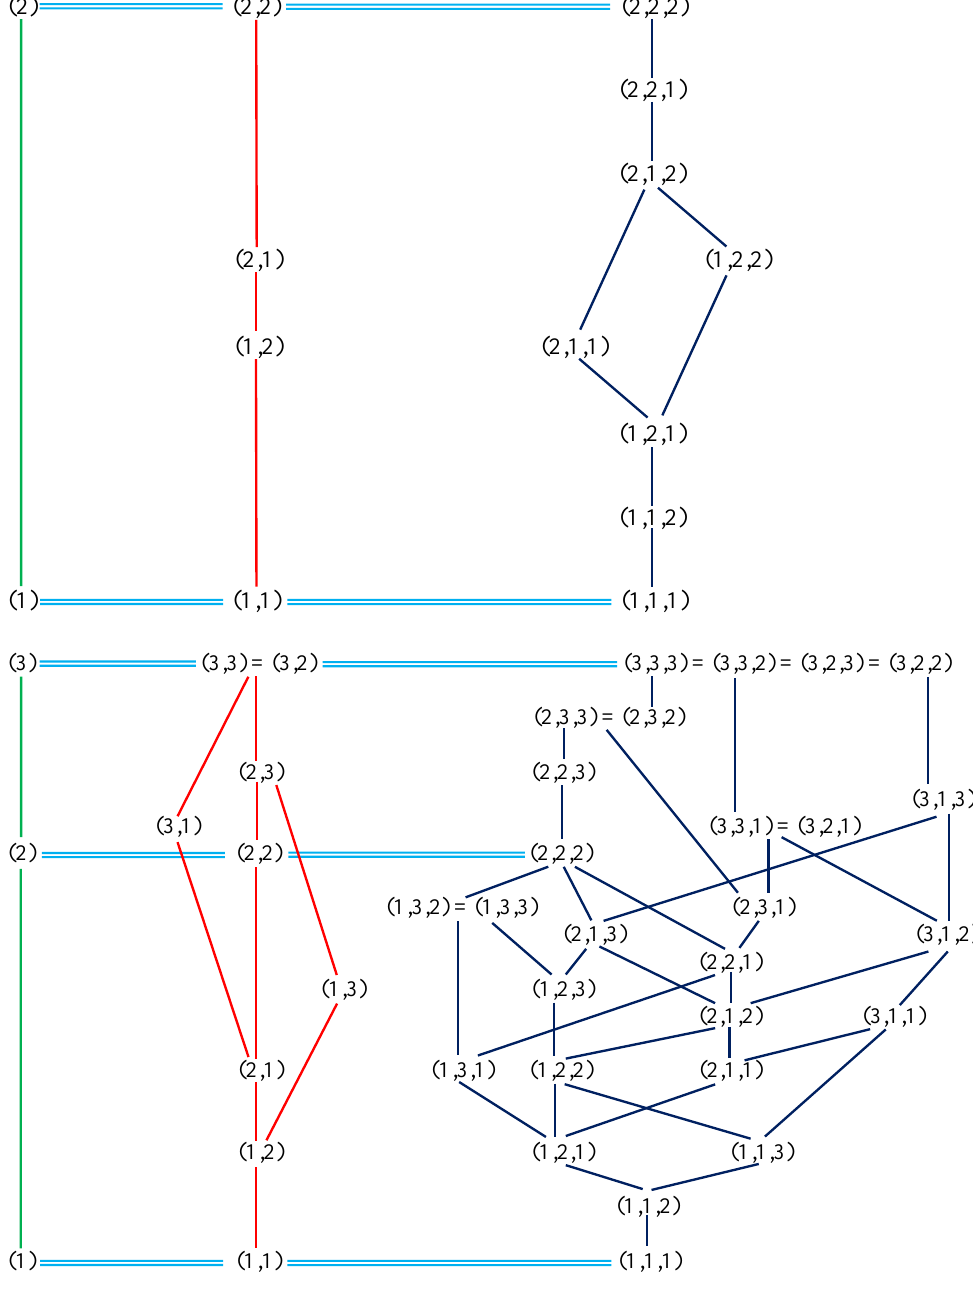
Figure 3. The Hasse diagrams of the partial orders ( S (cid:48) , ≥ ∗ ) (top) and ( T (cid:48) , ≥ ∗ ) (bottom) restricted to neighborhood sequences with periods 1, 2 and 3, from left to right,